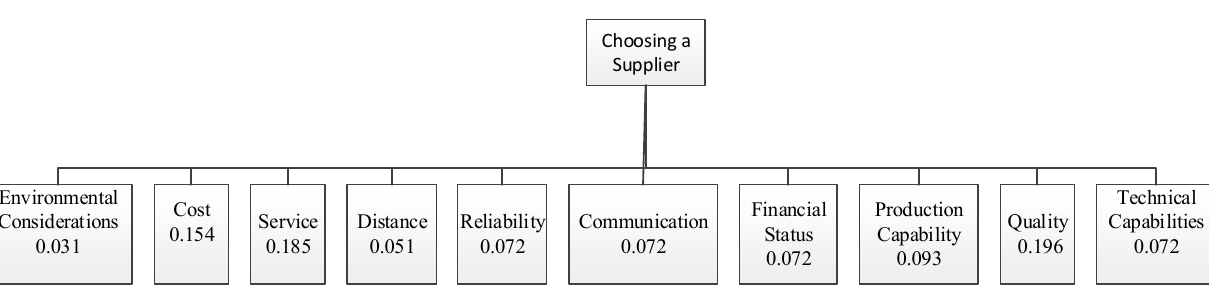
Figure 3. Supplier selection